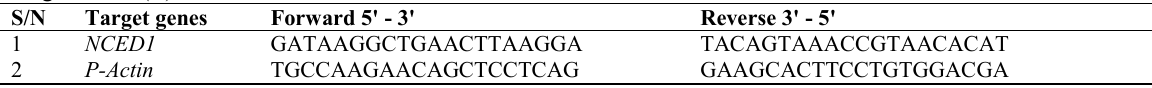
Table 2. Primer sequence of the candidate genes used for differential expression in cowpea under control (A) and drought stress (T)